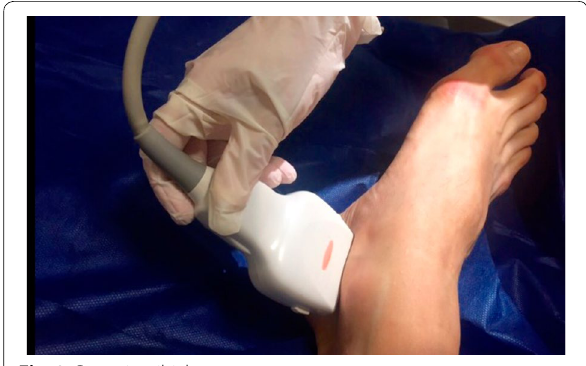
Fig. 2 Posterior tibial artery scan